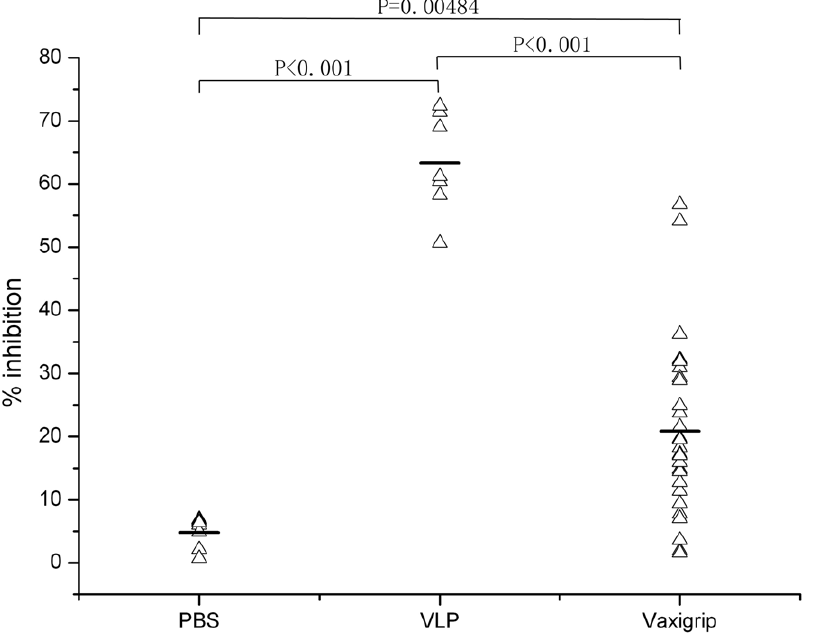
Figure 4. Statistical analysis of neutralizing antibody activity of immune sera at 1:20 dilution among three groups. Horizontal bars show the mean values of percentage inhibition in each of three groups. The data shown here were the combined results of two individual experiments.